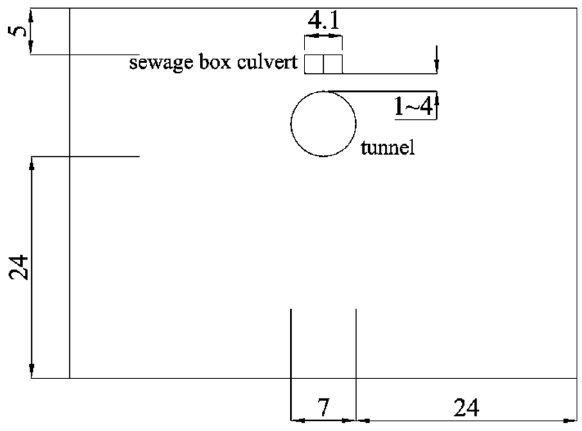
Figure 6. Model cross ‐ section dimension diagram (unit: m).